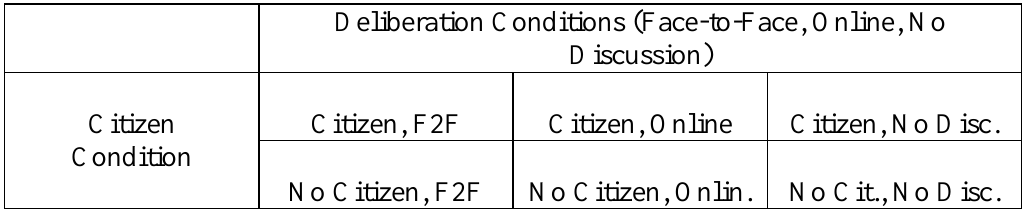
Table 1: VAProject Phase 1, 3X2